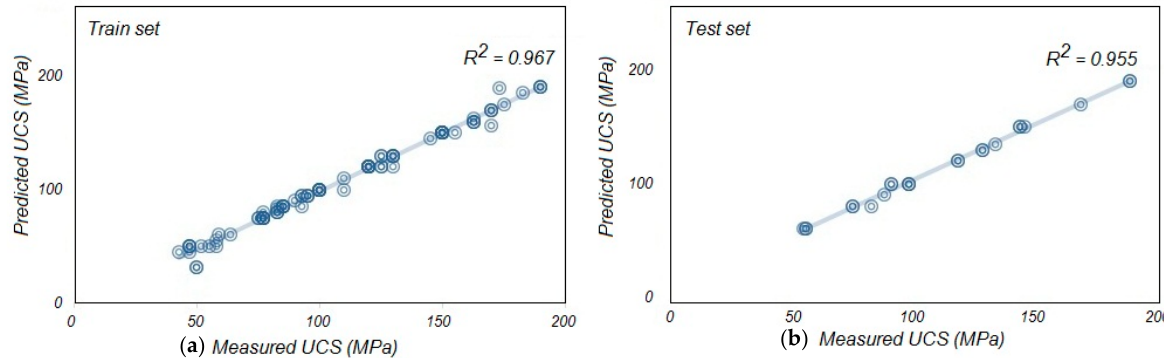
Figure 5. Correlation between the actual and predicted UCS results: ( a ) training set, ( b ) testing set.